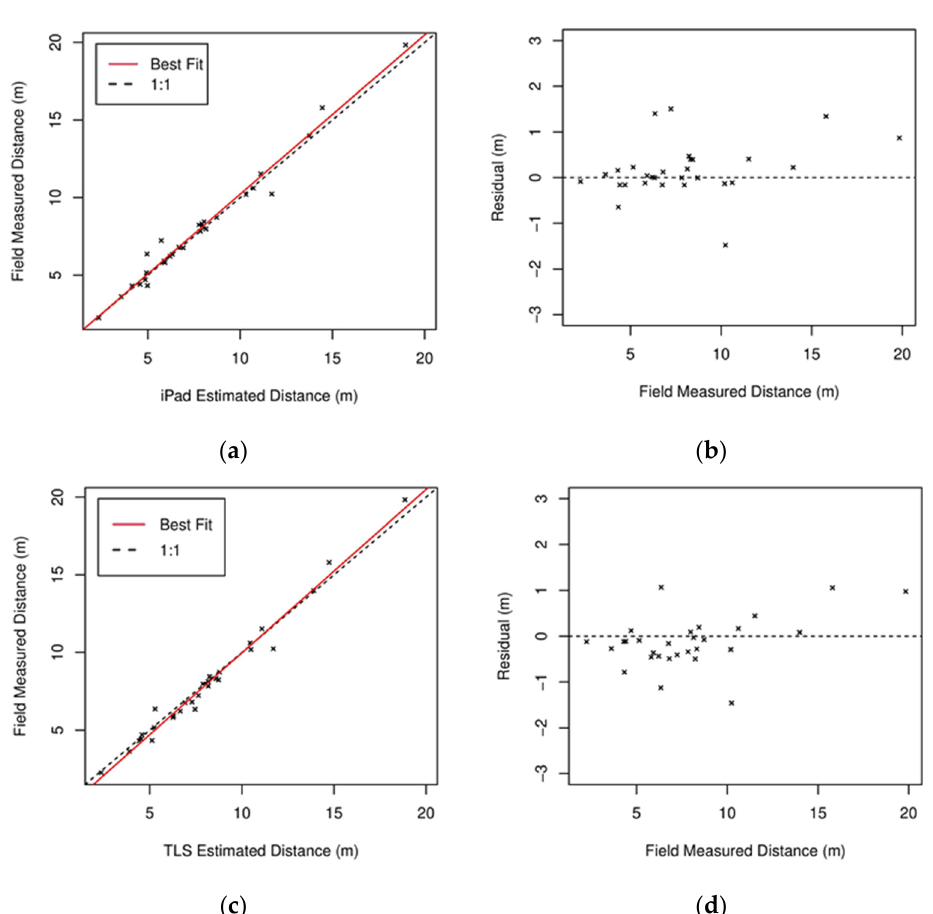
Figure 20. Distance comparison between iPad LiDAR and a conventional measurement method (laser distance meter) and distance comparison between TLS and a conventional method (laser distance) in stand: ( a , c ) the regression plots for the distance between trees determined from iPad LiDAR and TLS, while ( b , d ) shows the residuals for the estimated field measured distance.